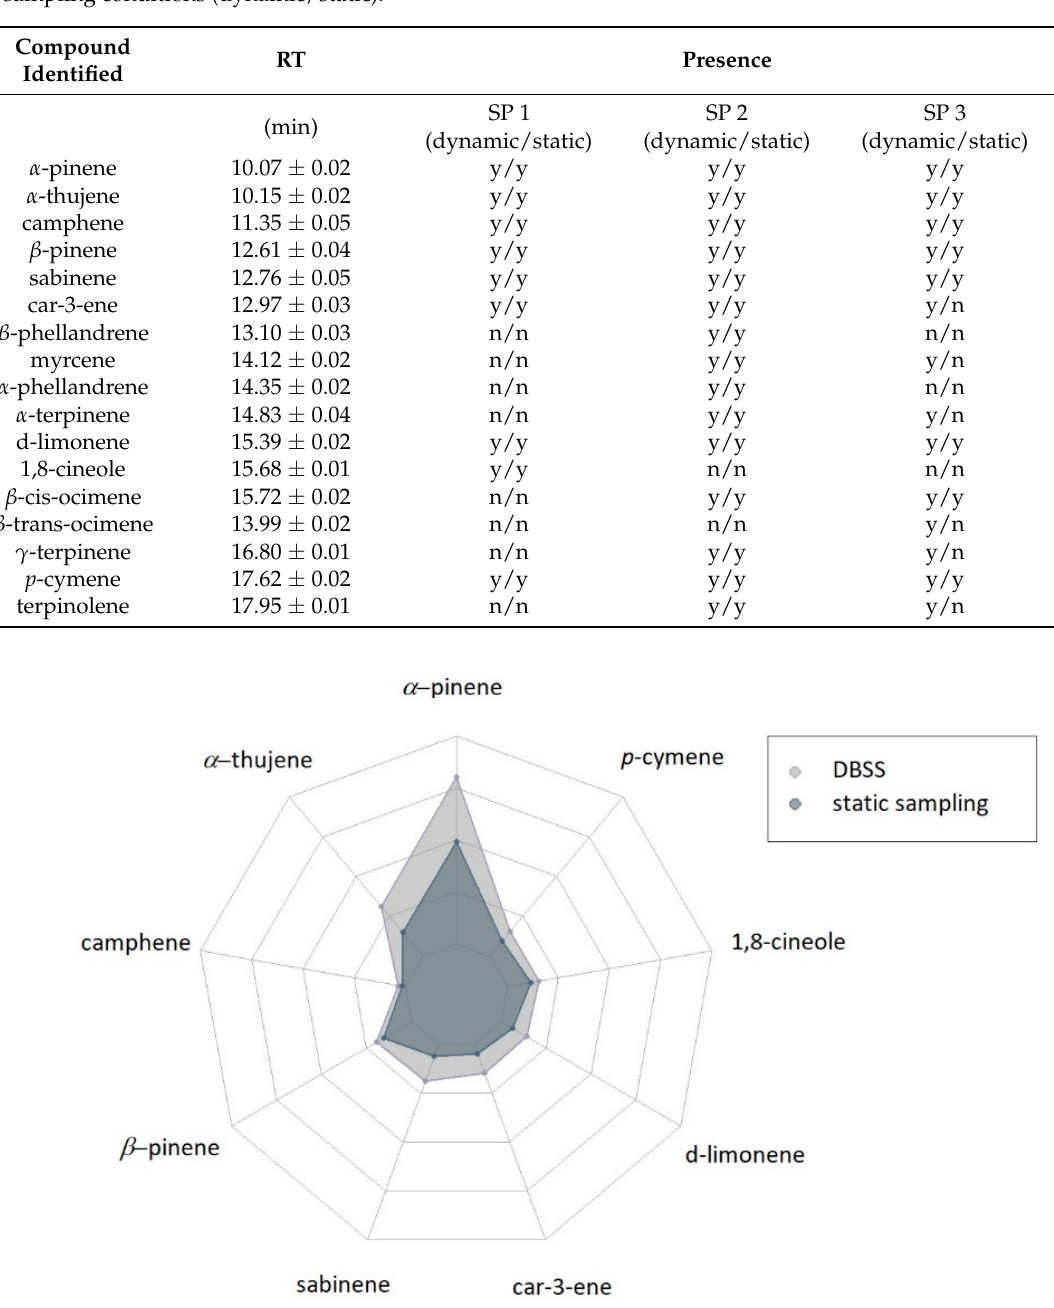
Table 1. A list of the identified compounds by comparison with the NIST 11 library. Their names and retention times (RT) are presented. The peak number (n. Peak) corresponds to the numbers reported in the chromatograms (Figure S1). It is also reported the presence (y: yes) or the absence (n: no) of each compound in each the different sampling points (SP 1, SP 2 or SP 3) and in the two sampling conditions (dynamic/static).